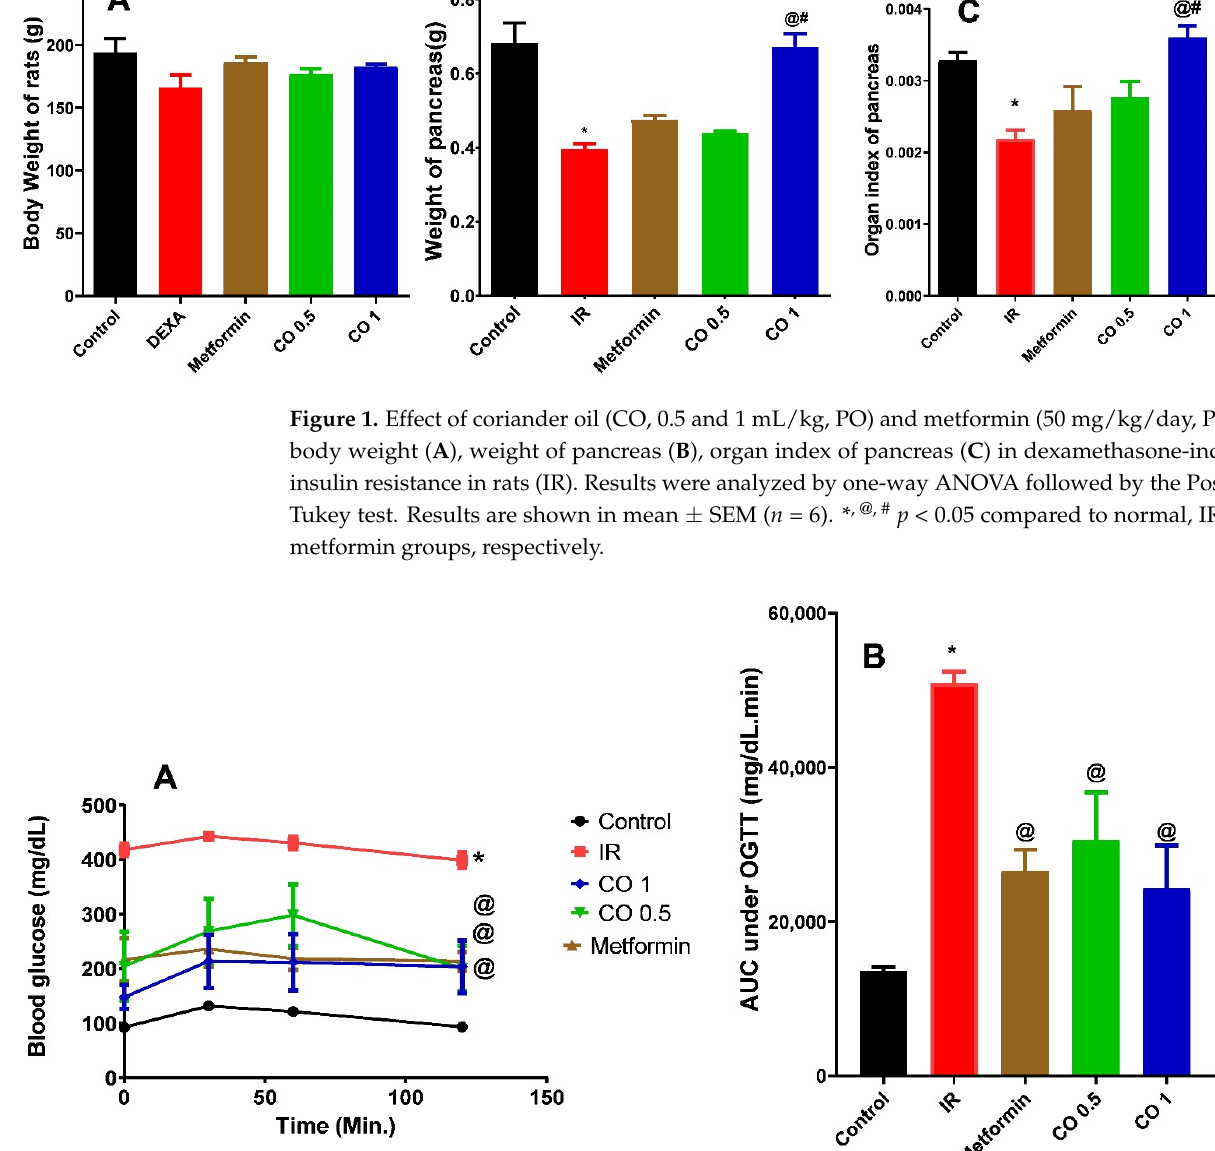
Figure 2. Effect of coriander oil (CO, 0.5 and 1 mL/kg, PO) and metformin (50 mg/kg/day, PO) on oral glucose tolerance (OGTT) test ( A ) and area under the curve ( B ) in dexamethasone-induced insulin resistance in rats (IR). Results were analyzed by one-way ANOVA followed by the post-hoc Tukey test. Results are shown in mean ± SEM ( n = 6). * , @ p < 0.05 compared to normal, and IR groups,